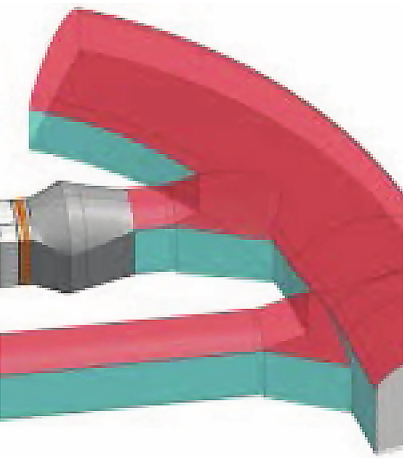
Fig. 11. Schematic representation of a full-scale test of a pos- sible design of a disposal tunnel end plug component by the POPLU experiment (Posiva).